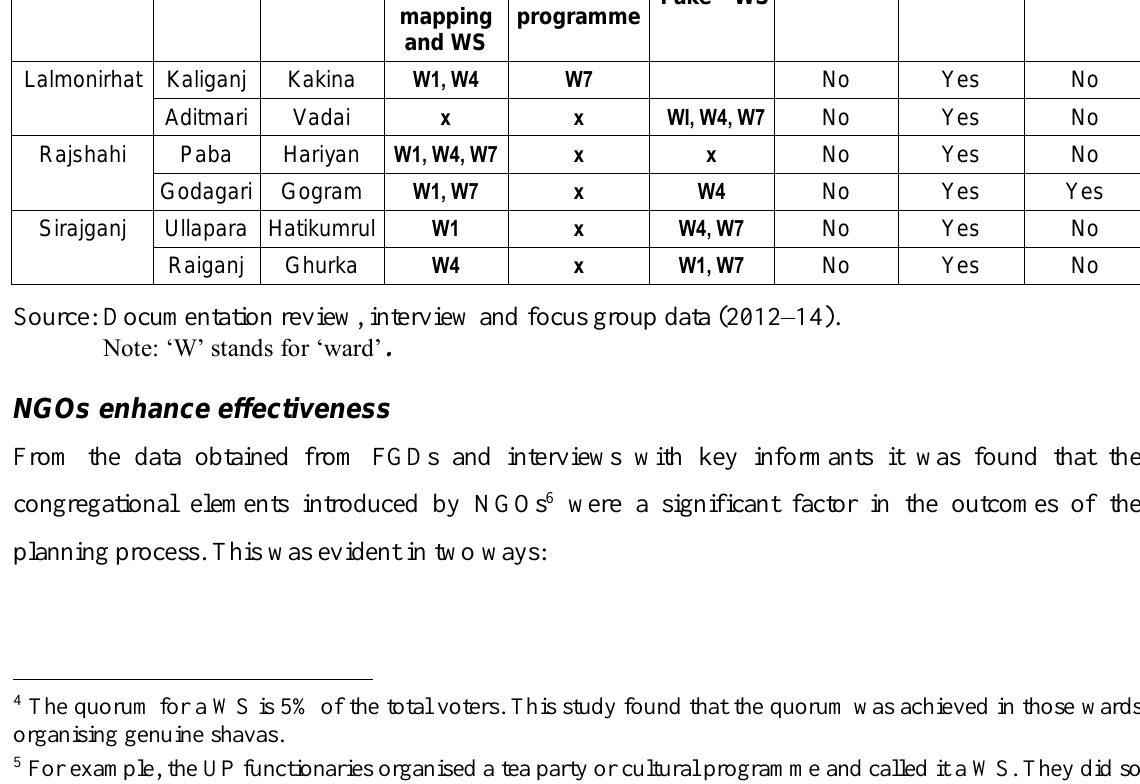
SC UDCC constituted constituted constituted Social